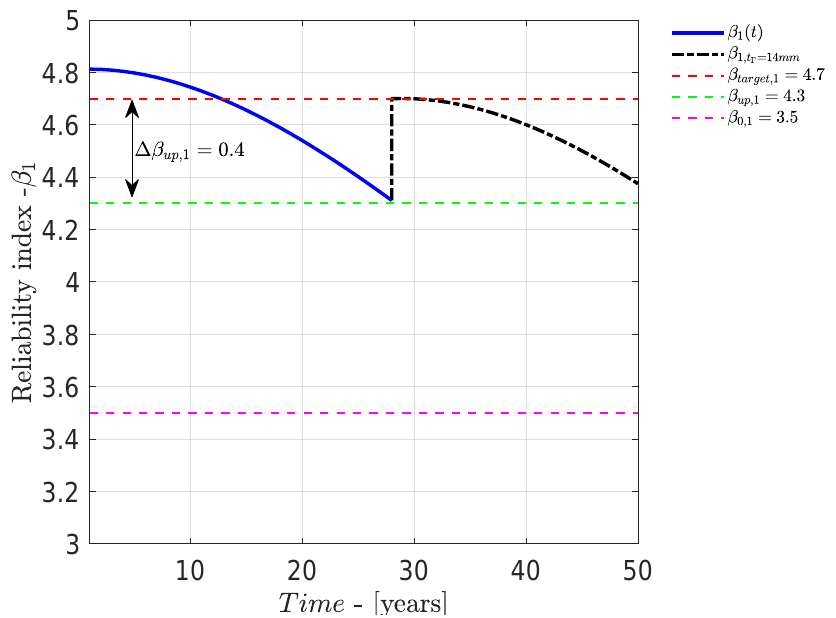
Figure 5. Evolution of the reliability index of the RC beam prior to strengthening strengthening (blue solid line) and after addition of 14 mm thick UHPFRC tensile layer at 28 years old (black dotten line).